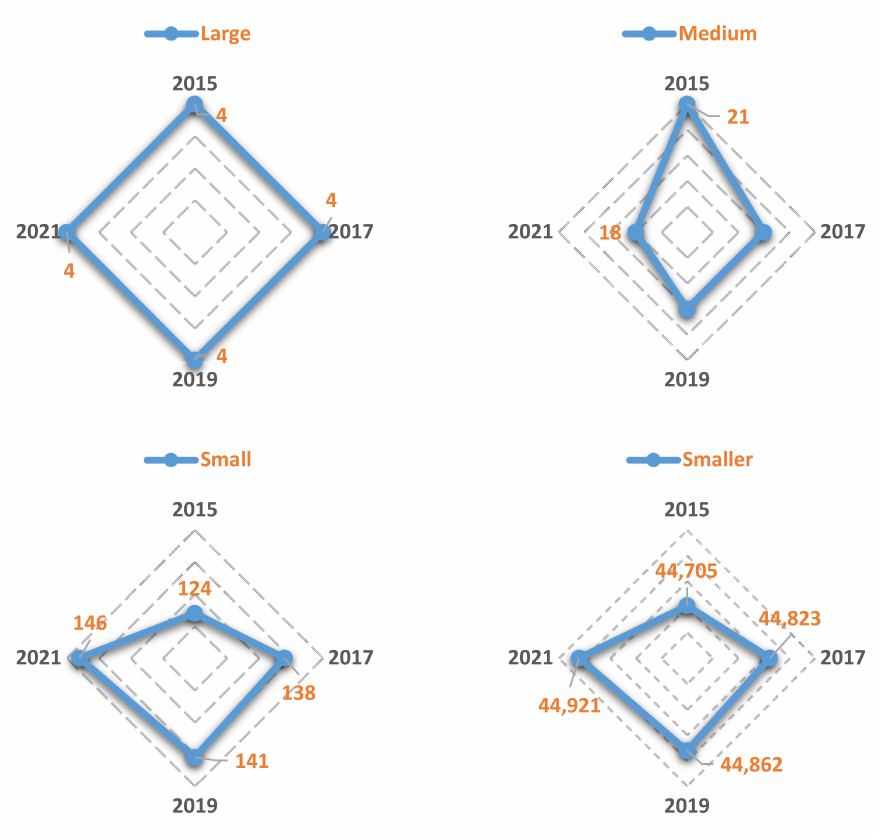
Figure 12. The changes in the number of glaciers at different scales.